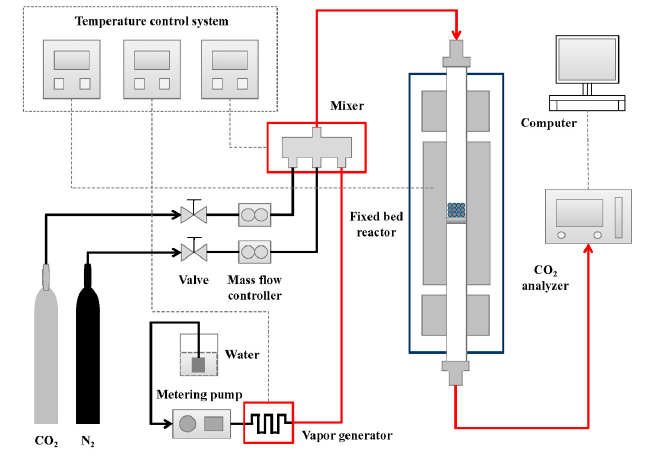
Figure 1. Schematic diagram of the preparation process of adsorbent.